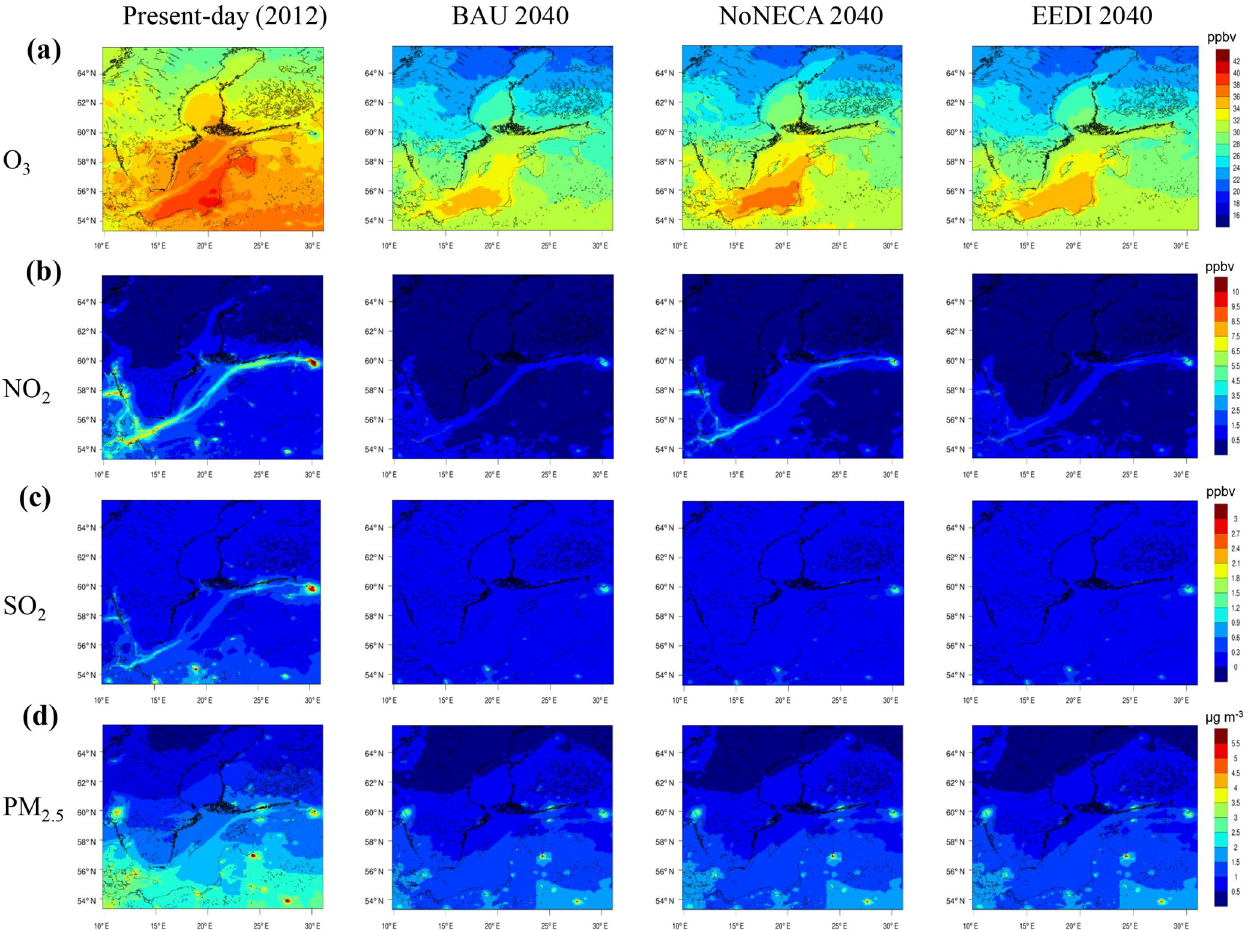
Figure 6. Future air quality situation in the Baltic Sea region in summer (JJA) compared to the present day. CMAQ model results for present- day (first column), for BAU 2040 (second column), for NoNECA 2040 (third column) and for EEDI 2040 (fourth column) are shown for (a) daily maximum O 3 , (b) NO 2 , (c) SO 2 and (d) PM 2 . 5